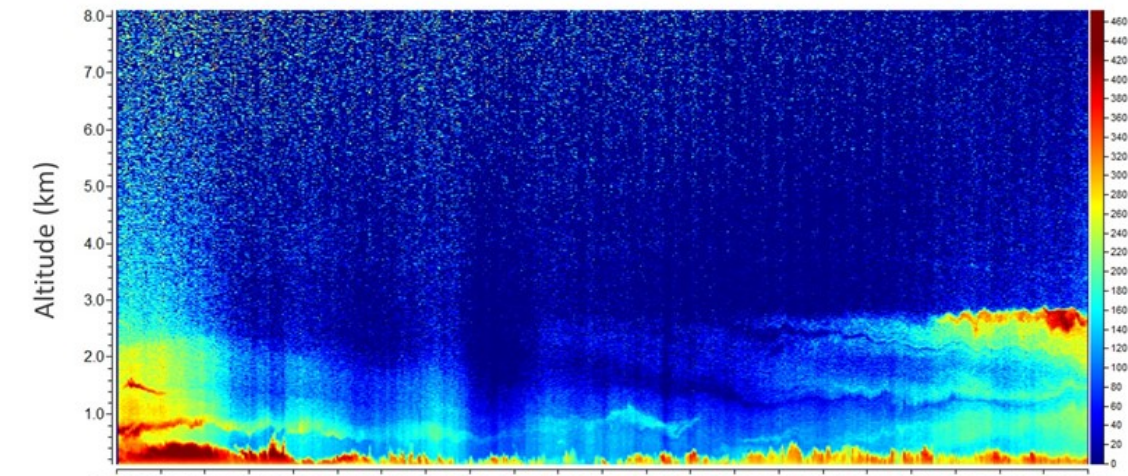
Figure 15. Time variability of the RCS lidar signal retrieved at 532 nm on 13 July 2017 from 05:48 to 16:48 UTC. The data have a spatial resolution of 15 m and a temporal resolution of 60 s.